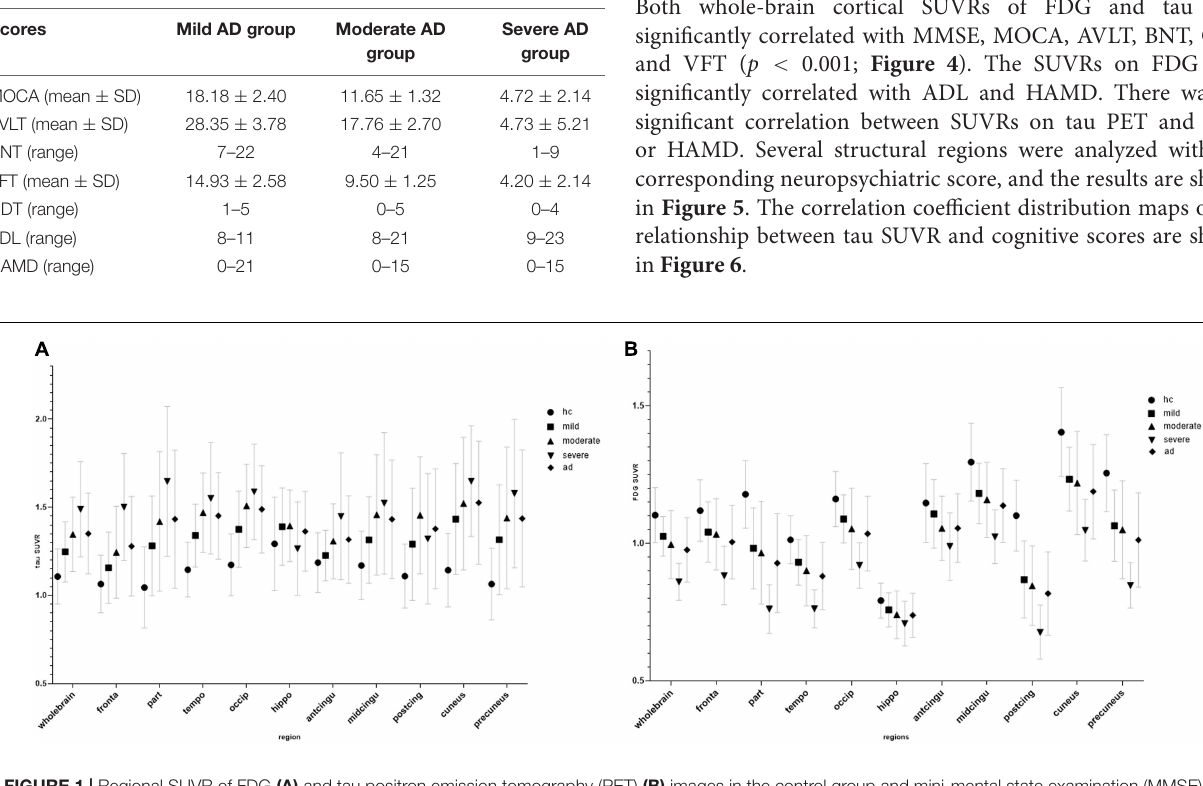
Frontiers in Aging Neuroscience |